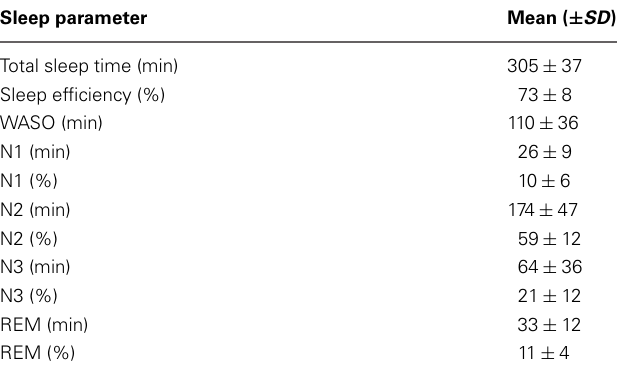
Table 1 | Mean and standard deviation (SD) of polysomnographic parameters (seven subjects, 44 study nights).